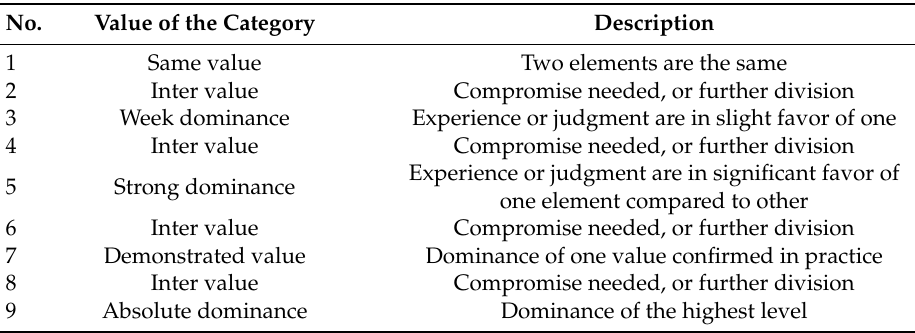
Table 5. The Saaty